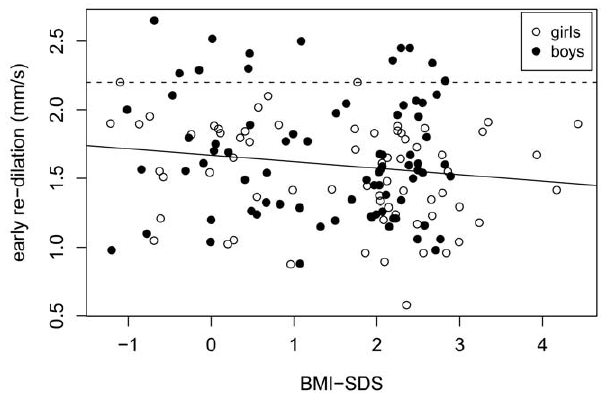
Figure 4. Correlation between early re-dilation (index of sympathetic nervous system) and BMI-SDS in 149 normal- weight and obese children. Pearson’s correlation coeffi- cient= 2 0.15, 95% CI=[ 2 0.30, 0.02], (p=0.08). Note that only boys have values above 2.2 mm/s (dashed line). The average age of these boys was 11.1 and only one of them was older than 13. This helps explain the strong interaction between age and gender, i.e. that the age dependence for boys is significantly different than that for girls. The regression line showing the downward trend for increasing BMI-SDS is also shown (solid